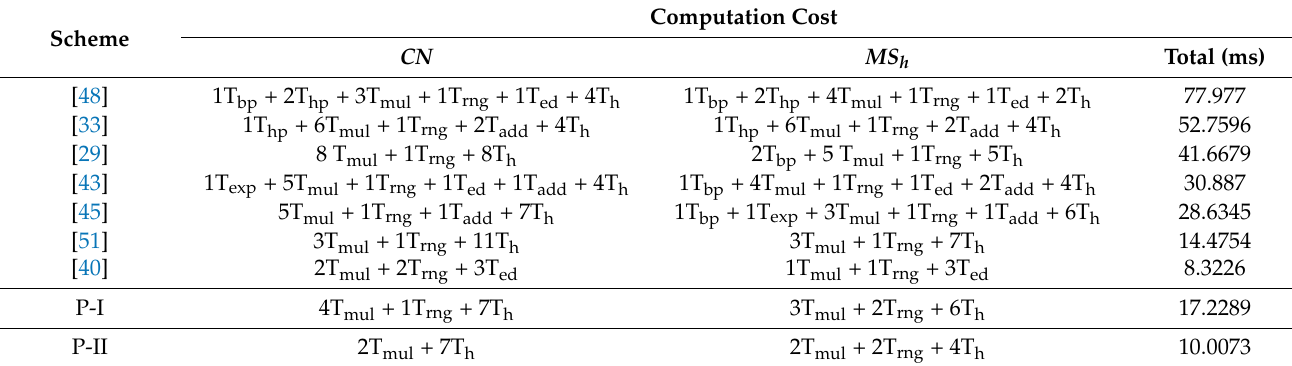
Table 4. A computation costs